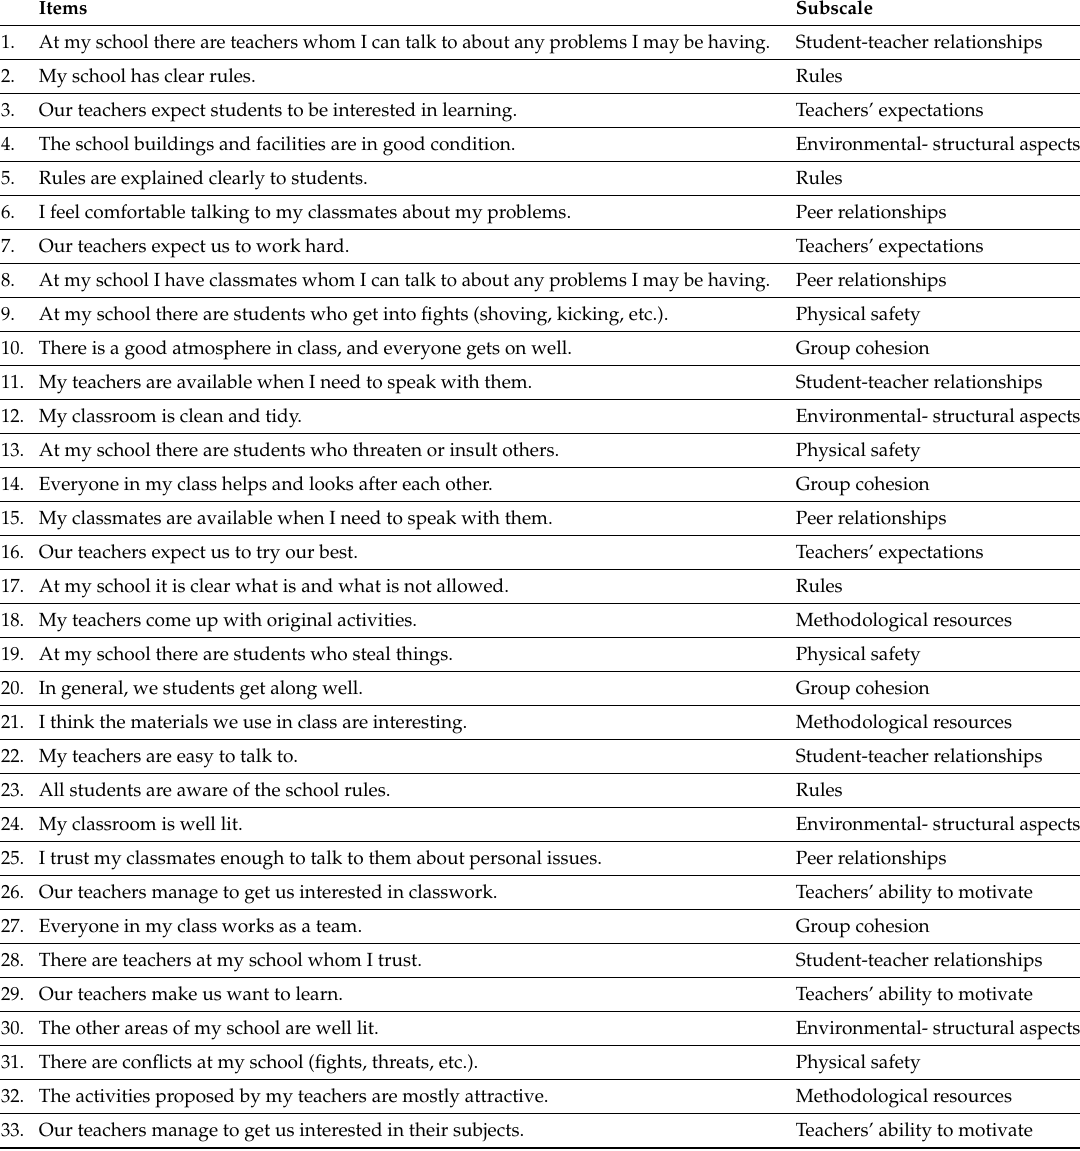
Table A1. Items of the PACE-33 in